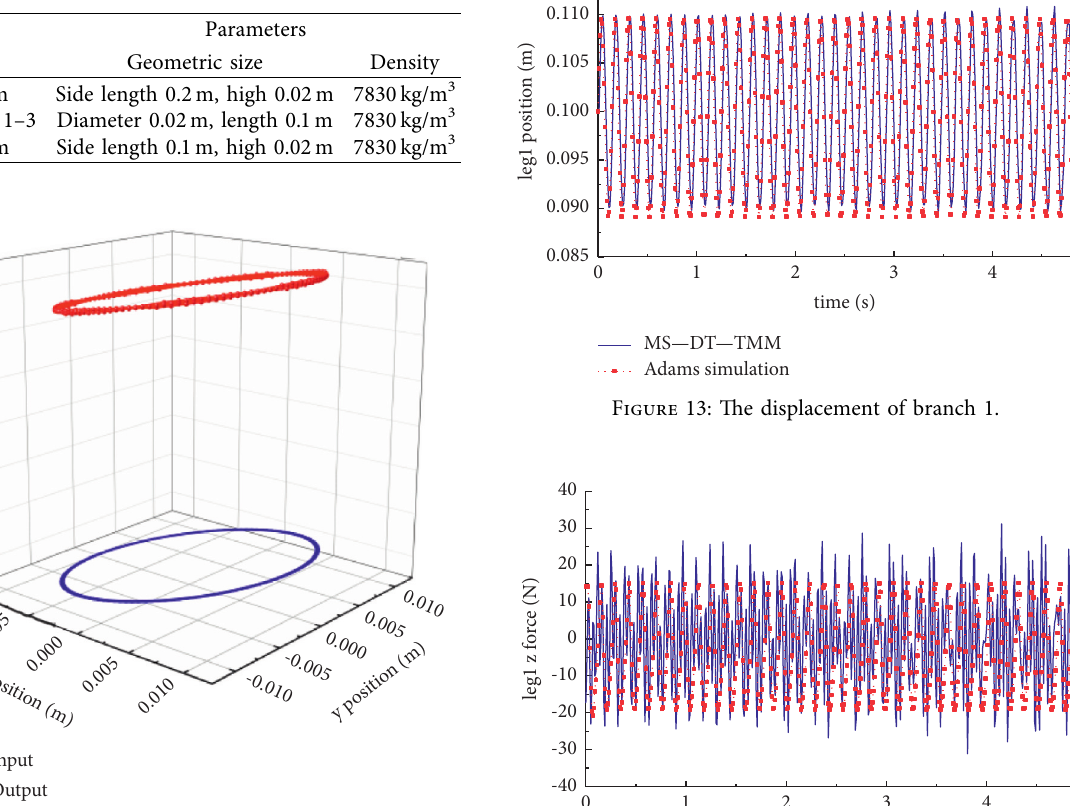
Figure 11: 3D model of the displacement excitation.